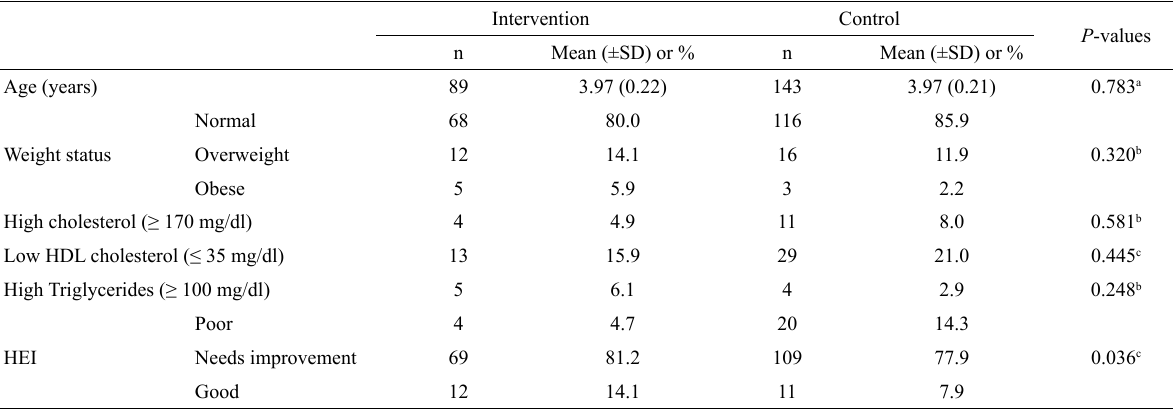
Table 2 – Health status of children at 4 years according to the studied